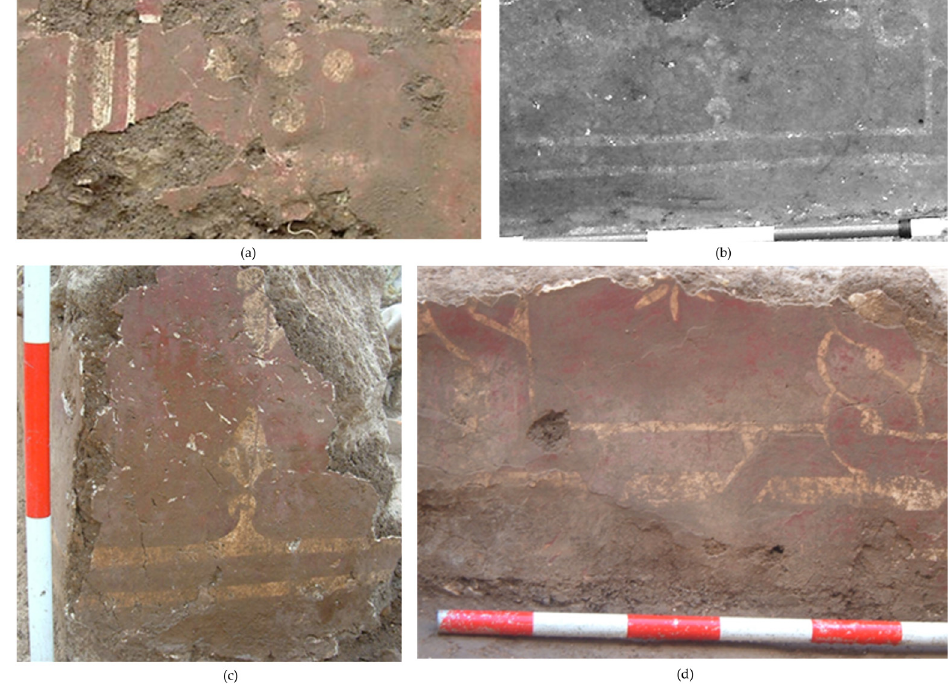
Figure 9. Vegetable elements in the 12th century, C ó rdoba: ( a – c ) Oller í as Avenue (Molina Exp ó sito 2004; L ó pez Jim é nez 2006); ( d ) Benito P é rez Gald ó s Street (Li é bana M á rmol 2008).